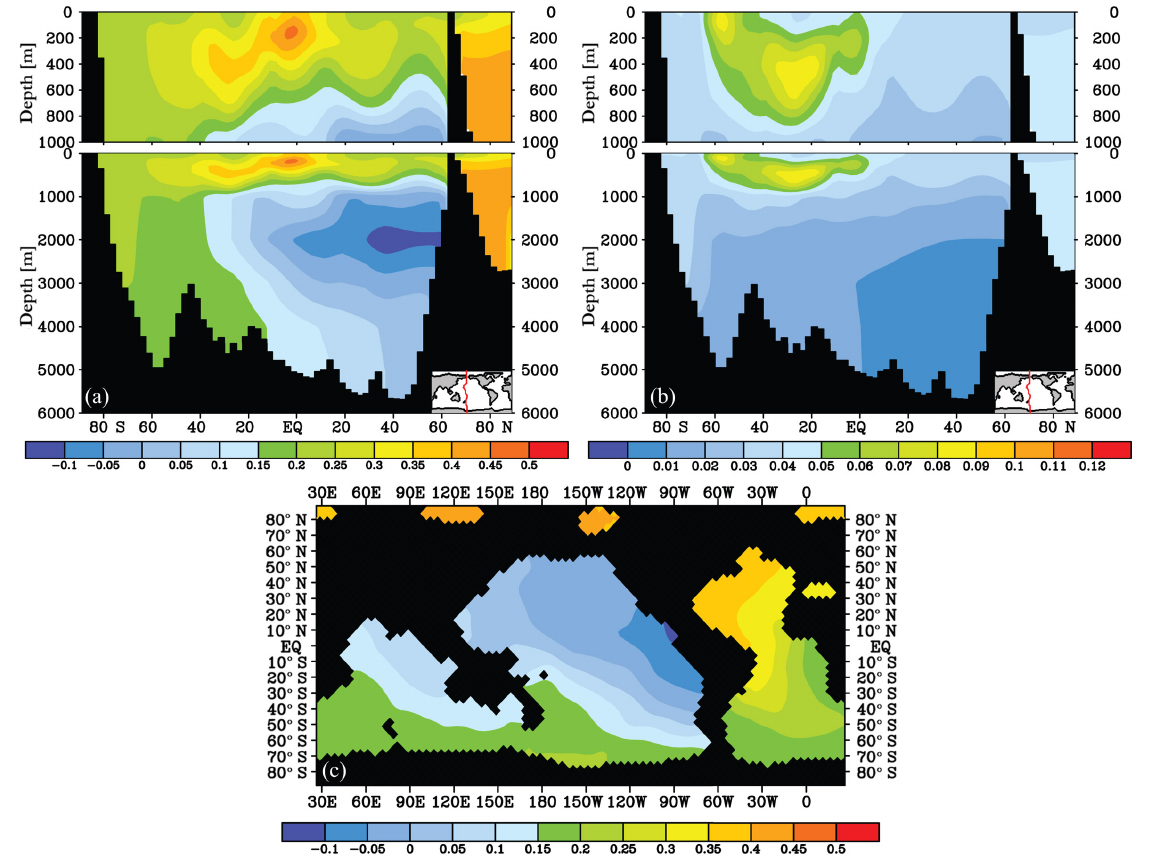
Figure 6. δ 13 C of DIC (‰) difference after 2000 years for the POC sinking rate experiments (experiment − control): (a) the global efficient biological pump (high POC sinking rate) experiment for a Pacific transect and (b) the SO-only efficient biological pump experiment for a Pacific transect and (c) the global efficient biological pump experiment at 3000m depth. Note the different